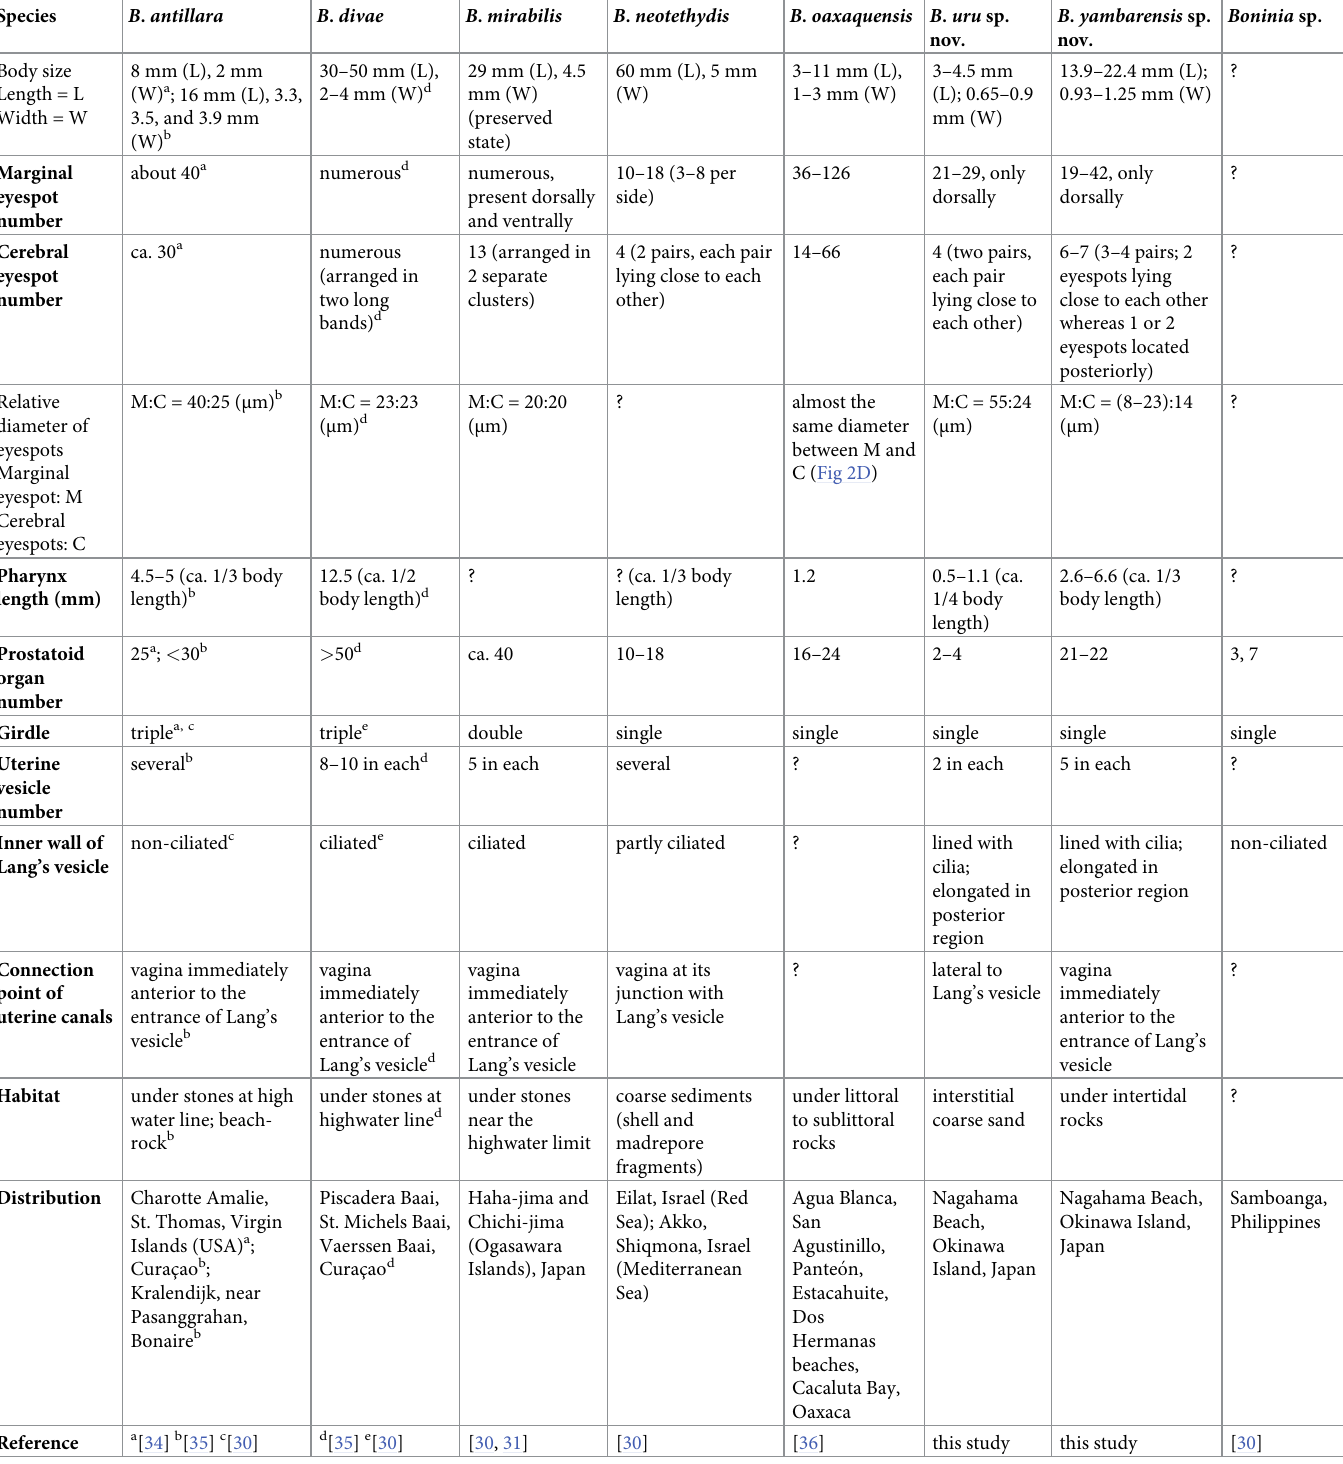
Table 4. Comarison of selected characters among Boninia